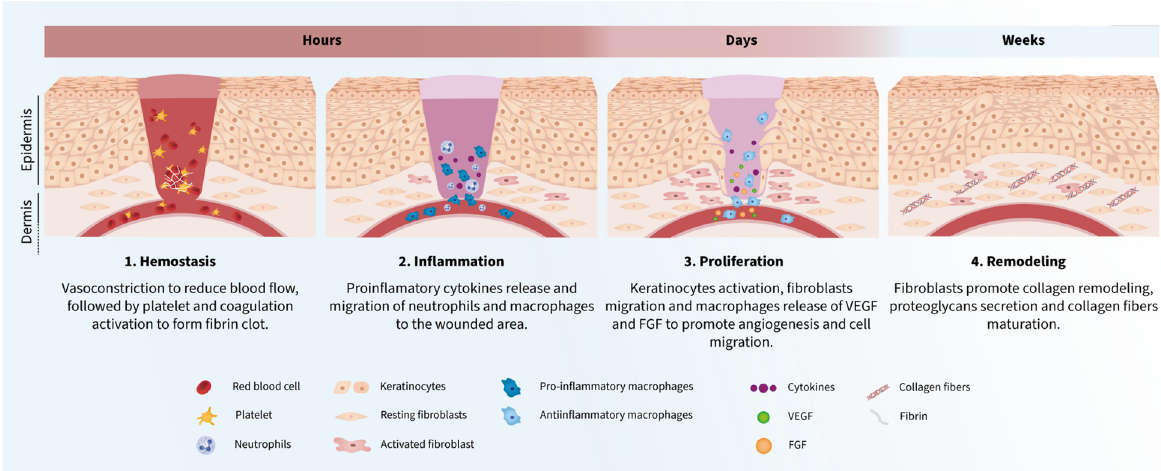
Figure 1. Wound healing process phases. 1. Hemostasis. Rupture of the veins adjacent to the wound area, infiltration of platelets and erythrocytes that begin the processes of platelet aggregation and coagulation that culminate in the fibrin clot formation. Tissue damage causes the release of mediators, such as proinflammatory cytokines, that will promote cell migration in later phases. 2. Inflammation. Infiltration of macrophages and neutrophils is enhanced by proinflammatory mediators to face infection and moderate inflammation. 3. Proliferation. Activation and migration of several cell types as keratinocytes and fibroblasts promoting angiogenesis and re-epithelization. 4. Remodeling. Fibroblasts orchestrate the ECM modulation for tissue regeneration.